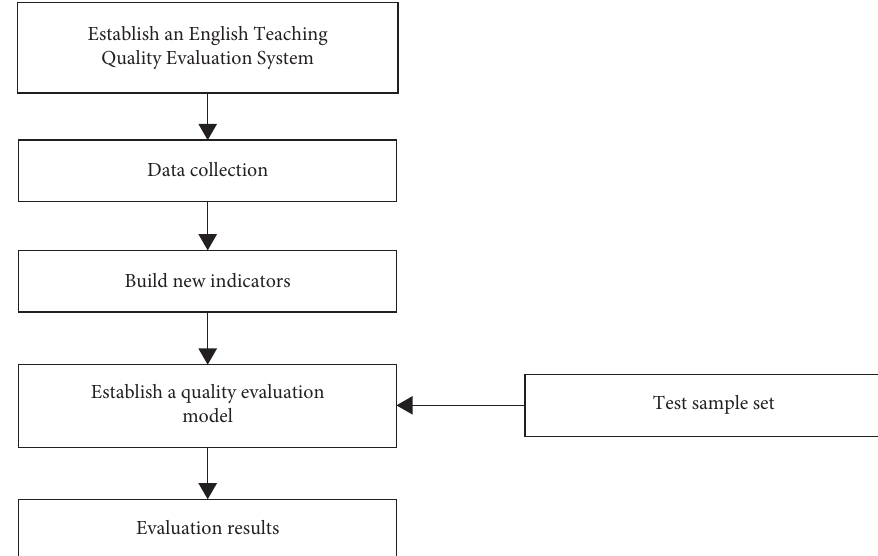
Figure 2: Process of English teaching quality evaluation.